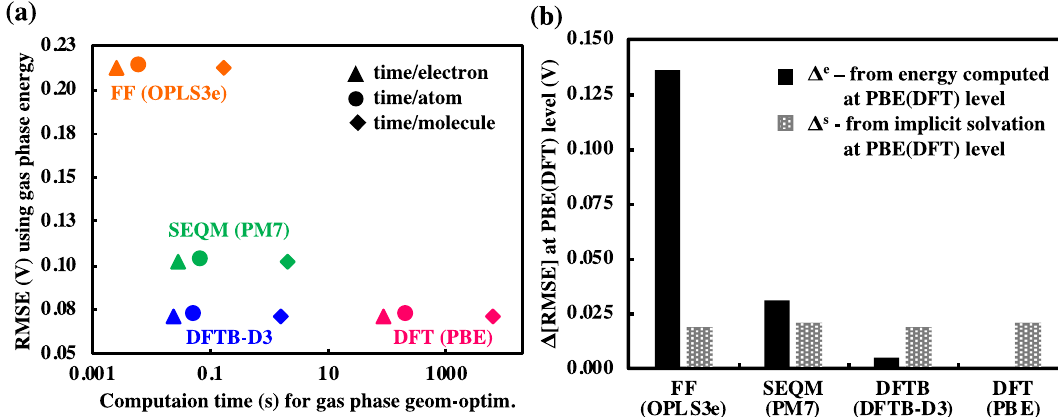
Figure 4. ( a ) Variation of computation time for gas-phase geometry optimizations versus the corresponding RMSEs from the four representative methods of each level of theory, namely OPLS3e (FF), PM7 (SEQM), DFTB-D3 (DFTB), and PBE (DFT). The SPEs are taken directly after optimization runs at corresponding levels of theory. A logarithmic scale is used when plotting the computation time. ( b ) Bar plot for change in RMSE values, Δ[RMSE], due to gas-phase DFT calculation of SPE and inclusion of implicit solvation. Solid bars, Δ e , show the impact of DFT calculation of SPEs on geometries obtained from lower level methods. Dashed bars, Δ s , show the impact of implicit solvation on the DFT calculated